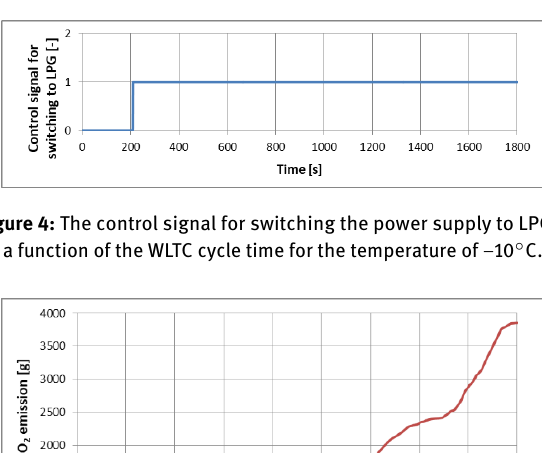
Figure 3: The course of carbon dioxide concentration as a function of the WLTC cycle time for the temperature of − 10 ∘ C.